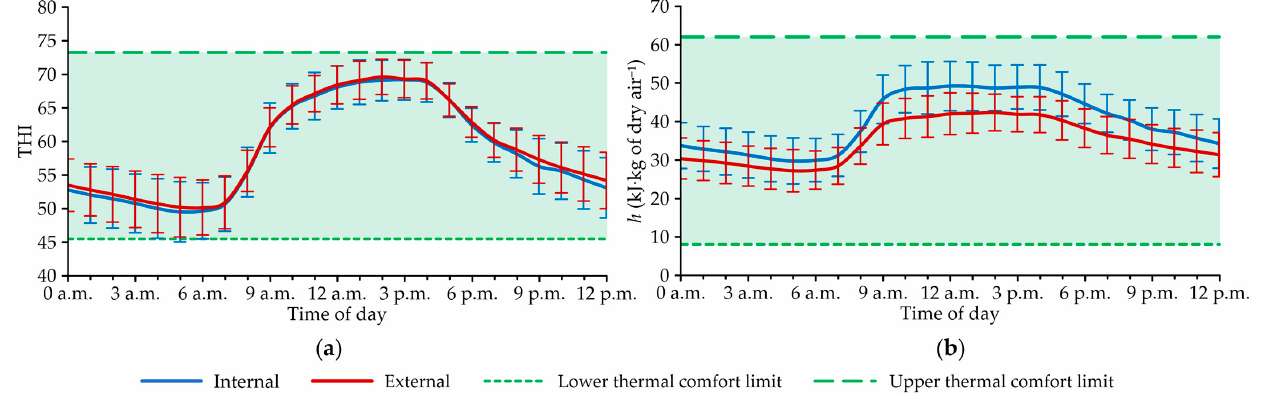
Figure 4. Average hourly profiles of the ( a ) temperature and humidity index (THI) and ( b ) specific enthalpy of air ( h , in kJ ∙ kg of dry air − 1 ) throughout the day in the internal and external facility environments, during the experimental period.